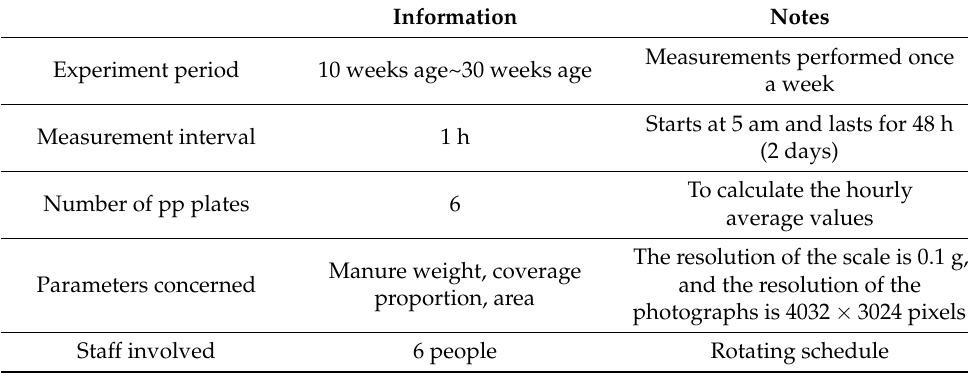
Table 1. Detailed information on the experimental measurements.